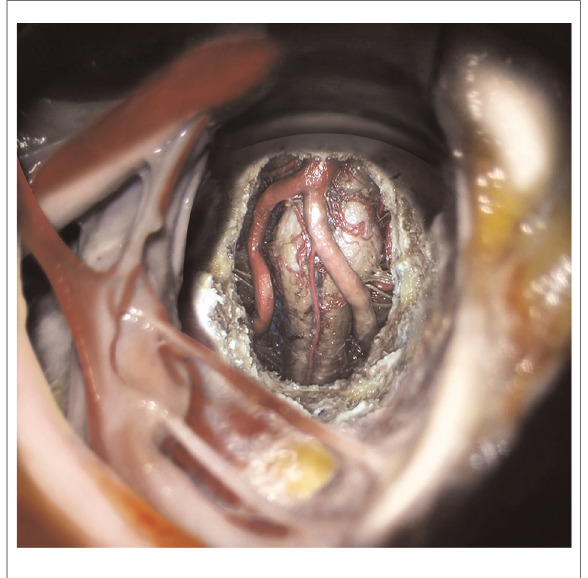
FIGURE 7 Artist ’ s illustration of the exposure of the high anterior cervical approach to the craniovertebral